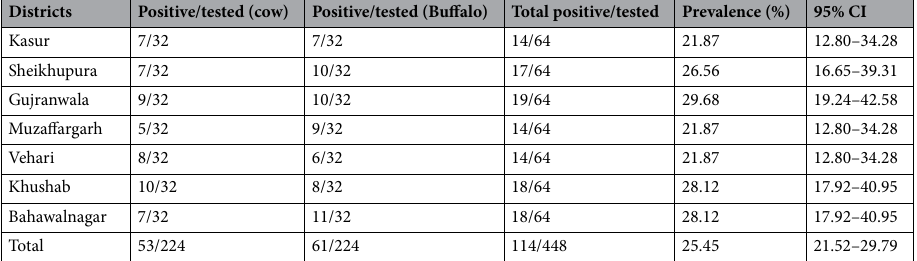
Table 2. Animal level seroprevalence of Q fever in large ruminants in Punjab, Pakistan.